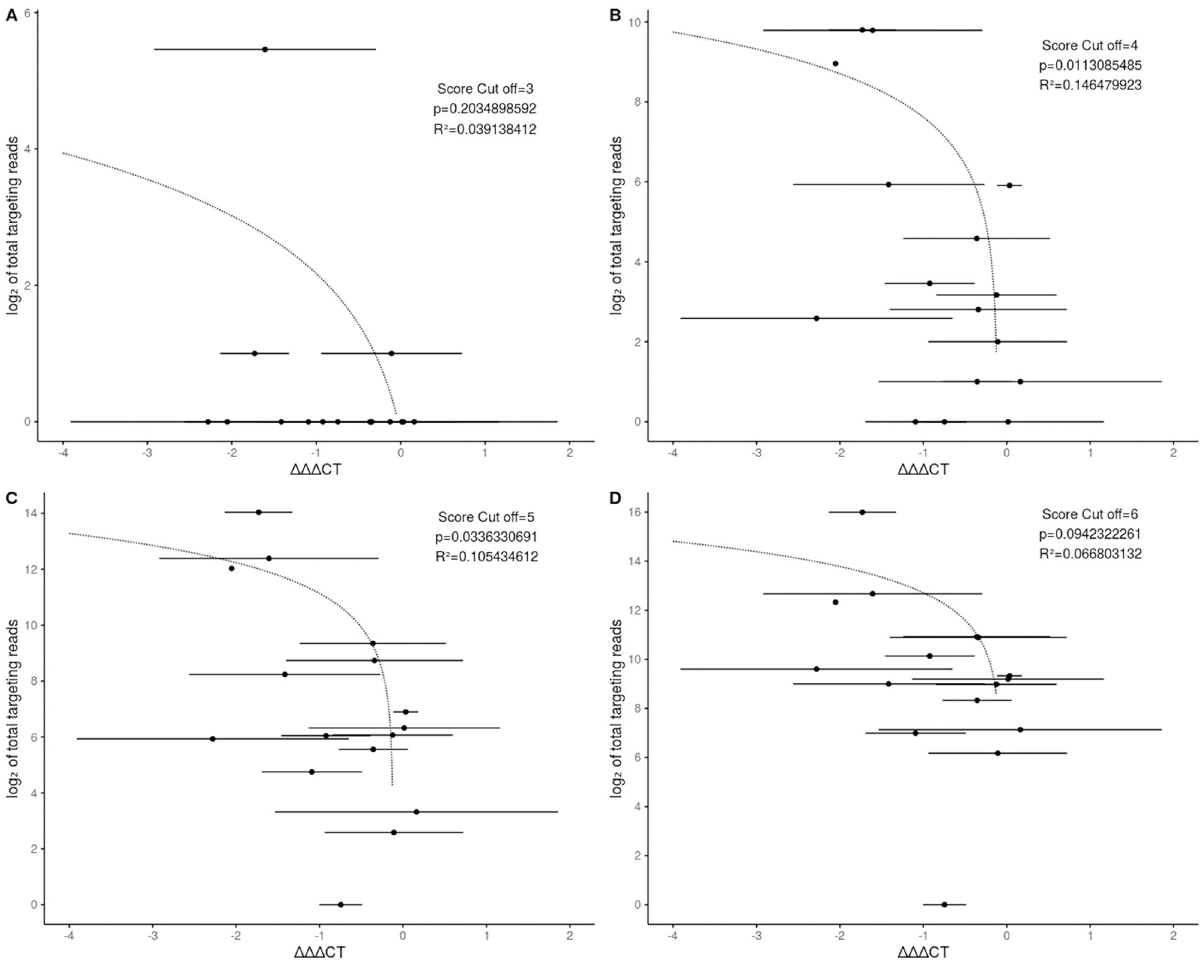
Fig 7. The degree of DCL-dependent gene silencing is correlated with the number of homologous fungal sRNAs. Each dot represents a predicted target gene of Fg -sRNAs. On the x-axis the ΔΔΔ ct-value is shown with bars representing SD. On the y-axis the log 2 of the number of total sRNAs potentially targeting each gene are shown. The dotted line represents a linear regression model. P indicates the significance (t-test) of the model and the score cut-off indicates the score limit used during the target prediction. Plot A, B, C and D are the calculations for a score cut off of 3, 4, 5 and 6